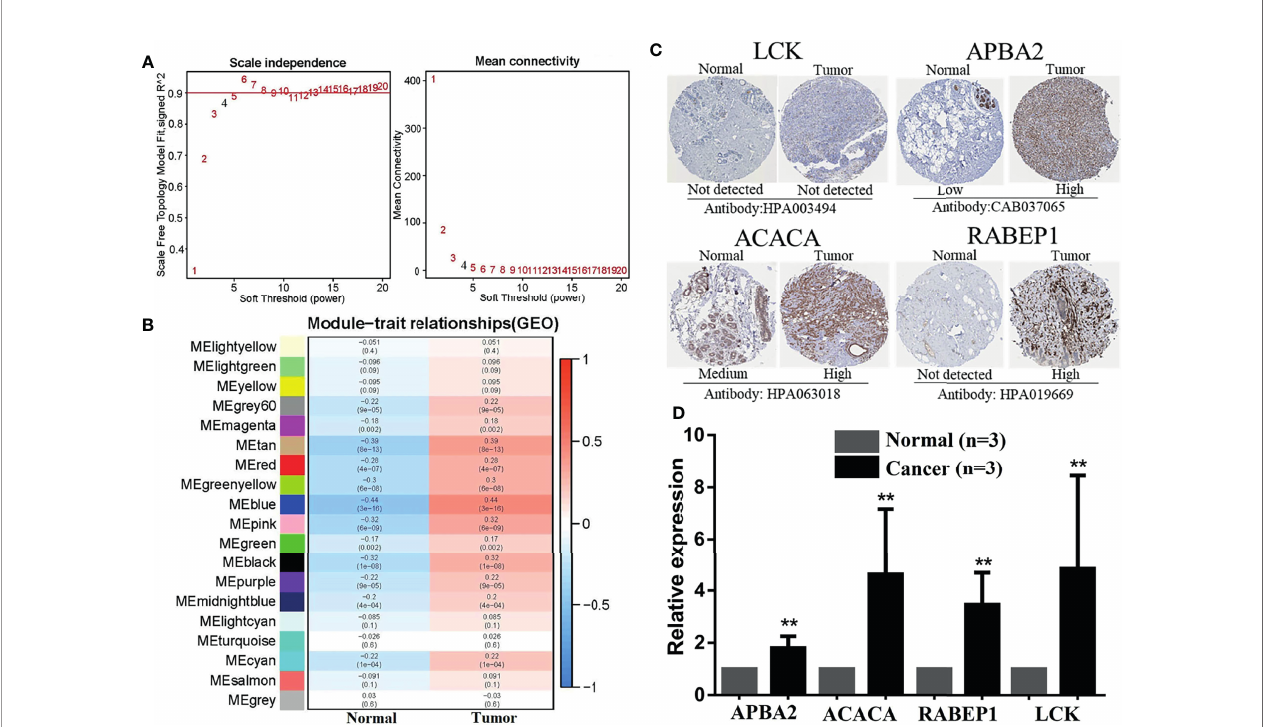
FIGURE 8 | Identi fi cation and exploration of hub DECIRGs pairs. (A) Determination of soft-thresholding power. When soft threshold comparable to 4, R 2 > 0.8 and mean connectivity < 100, the network was scale-free topology. (B) Module – trait associations: Each row corresponds to a module and each column to a trait (low- risk and high-risk). (C) The IHC staining images of LCK , APBA2 , ACACA , and RABEP1 . (D) The mRNA expression analysis of LCK , APBA2 , ACACA , and RABEP1 by qRT-PCR. **p <